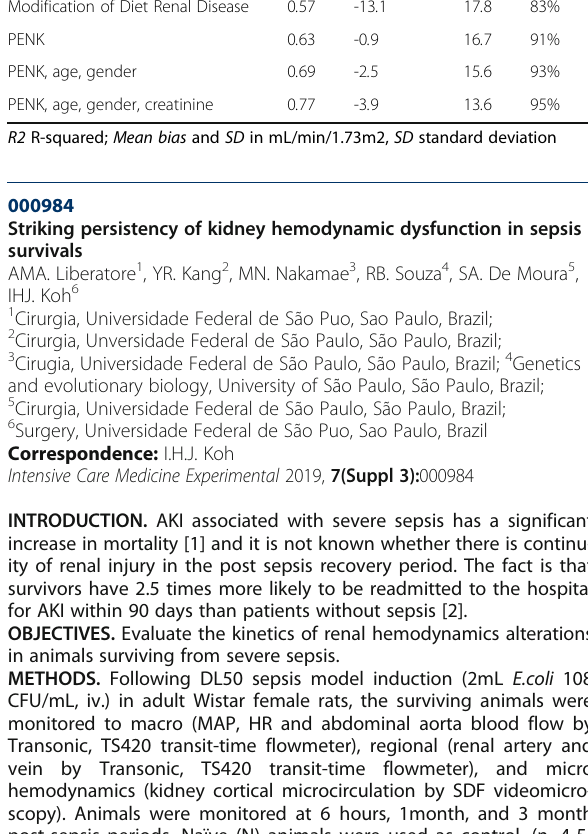
Table 1 (abstract 000963). Equations compared to the true GFR calculated using plasma clearance of iohexol Equation R2 Mean